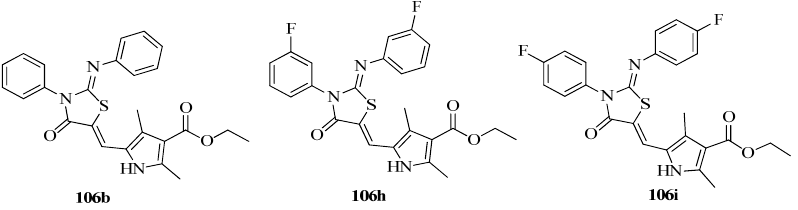
Figure 42. Structure of 2-imino-3-substituted 5-heteroarylidene-1,3-thiazolidine-4-one derivatives. Ganou et al. [160] evaluated the PTP1B inhibitory activity of ten previously synthe- sized thiazole derivatives. Among all compounds, compound 107 (Figure 43) was the most active with an IC 50 value of 18 µ M. Molecular docking studies revealed that compound 107 can bind to the catalytic site of PTP1B with its thiazole moiety, forming a pi–pi interaction with the amino acid Phe182, while ethylamino substituted formed a hydrogen bond with residue Asp181. Structure–activity relationship studies showed that the positions and the nature of substituents in the benzene ring would affect the activity of the compounds. Compounds with the 3-bromo group on the benzene ring showed better inhibitory activity, whereas compounds with ethylamino substituents exhibited higher inhibition than the corresponding methylamino substituents.